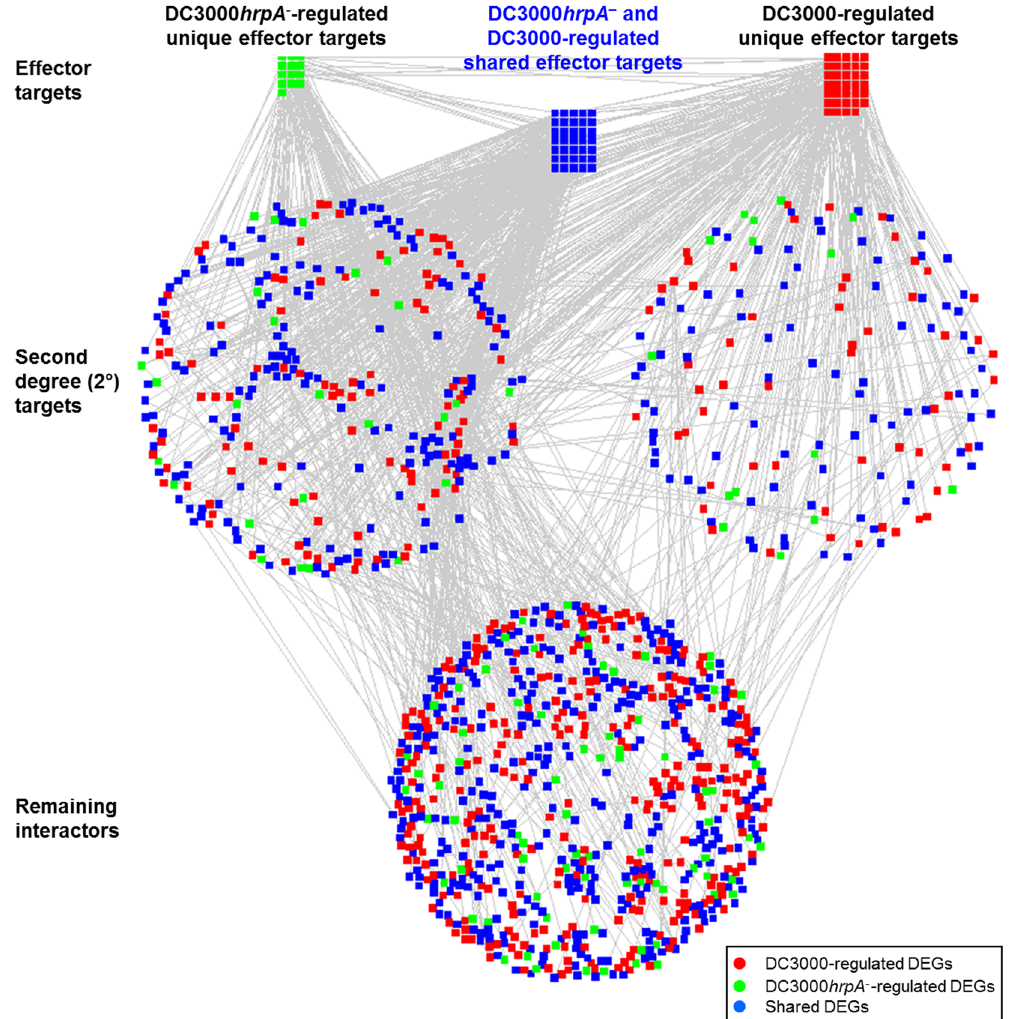
Figure 3. Visualization of DC3000 hrpA − and DC3000-regulated effector targets. Unique and shared effector targets that are differentially expressed by DC3000 hrpA − and DC3000 in AI- MAIN are illustrated in the first layer of the network. Second degree targets and remaining proteins make second and third layers in AI- MAIN , respectively. Non DEGs are removed from AI- MAIN for